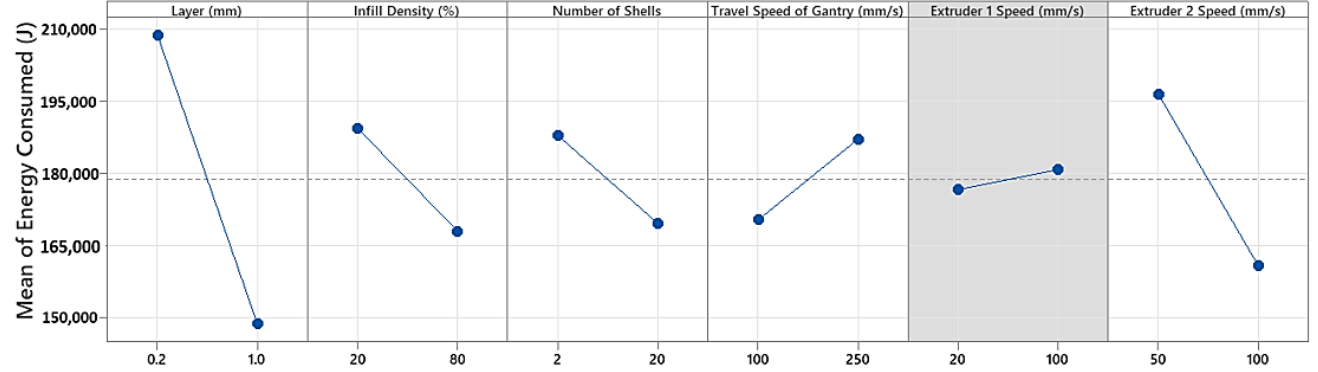
Figure 5. Main effects plot of energy consumption at the two levels. Pareto plots of the effects reveal the more prominent and likely significant effects. Significant terms deviate from the straight line near the normal effects plot’s center or exceed the Pareto chart’s threshold. The theory is that the insignificant terms are normally distributed based on the central limit theorem; hence, only terms deviating from that normal trend are likely significant. Independent parameter interactions (BF, AF, AB) are the terms that appear likely significant based on the effects shown in Figure 6. Interactions of extruder 2 speed and infill density or layer height are also effective compared to other variables. Based on the Pareto chart, layer height (A), the interaction of extruder 2 with infill density or layer height (BF and AF), extruder 2 speed (F), infill density (B), number of shells (C), and gantry travel speed (D) are the significant factors at a 5% significance level for the energy consumption. The interaction effects are shown in Figure 7, which implies that there exist significant interactions between layer height and infill density, layer height and extruder 2 speed, and infill density and extruder 2. However, all other interactions are insignificant regarding energy consumption.